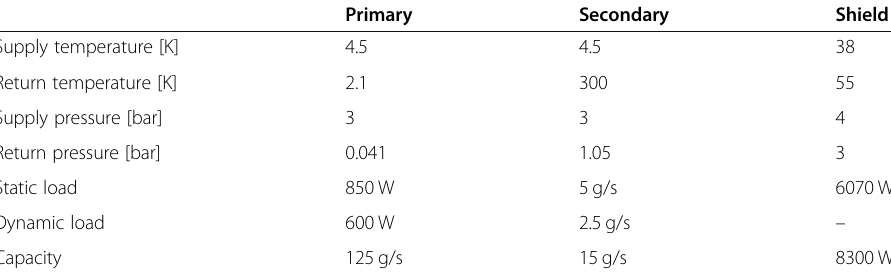
Table 1 SNS cryogenic system